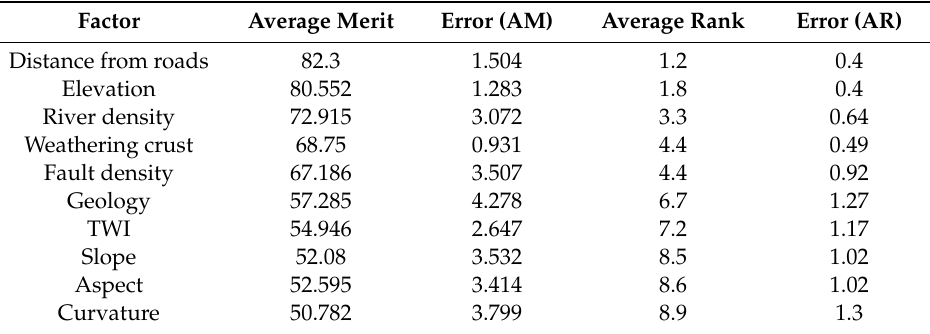
Table 1. Factor significance measured using the One-R